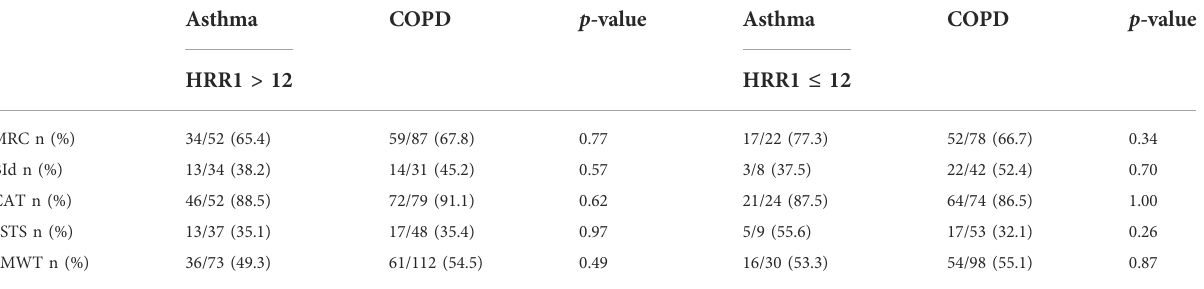
TABLE 5 Proportion of patients reaching the MCID after pulmonary rehabilitation. Asthma COPD p -value Asthma